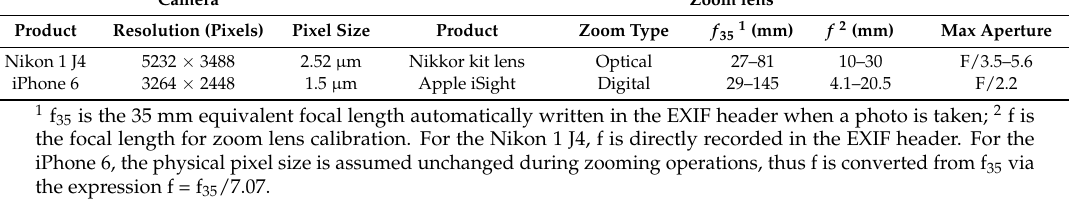
Table 1. Physical properties of the two zoom lens devices employed.